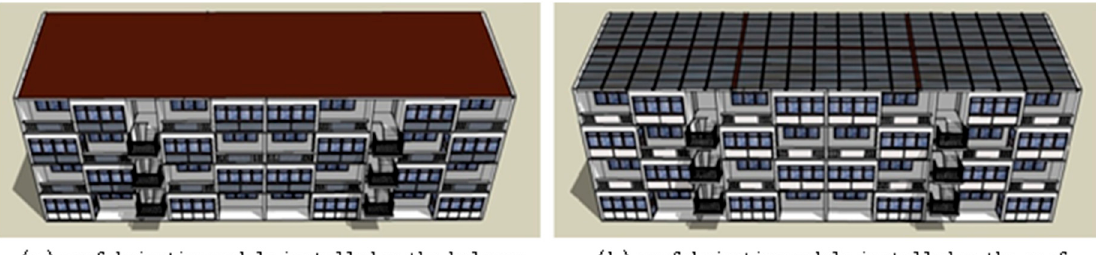
Figure 6. Outdoor appearance of the model building.